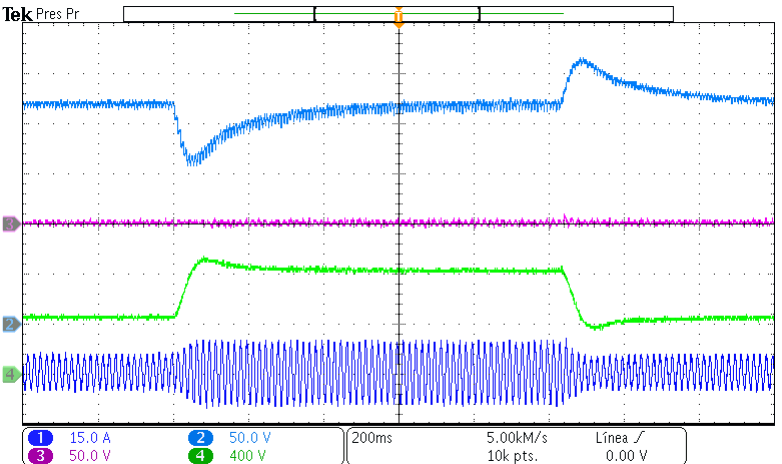
Figure 15. Transient responses during NLL stepwise changes of: (CH1) the sum of the capacitor voltage x 2 (y-axis 50 V/div); (CH2) the difference of the capacitors voltages x 3 (y-axis 50 V/div); (CH3) the power reference p ∗ calculated in the regulation loop (y-axis 50 V/div); and (CH4) the grid current i G